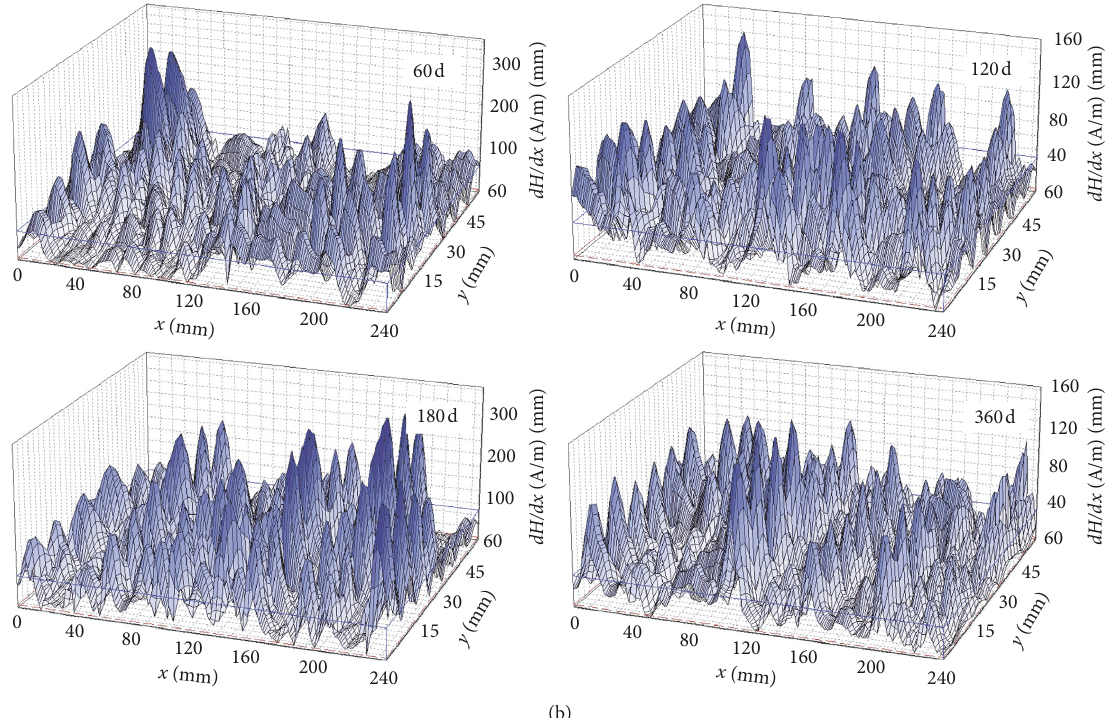
Figure 12: Evolution law of magnetic field gradient on surface of welded structure. (a) Welded structure processed by VSR. (b) Welded structure unprocessed by